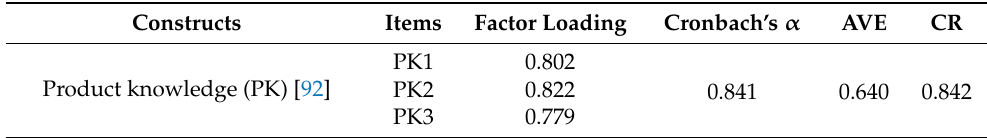
Table 2. Results of factor loading, reliability, and